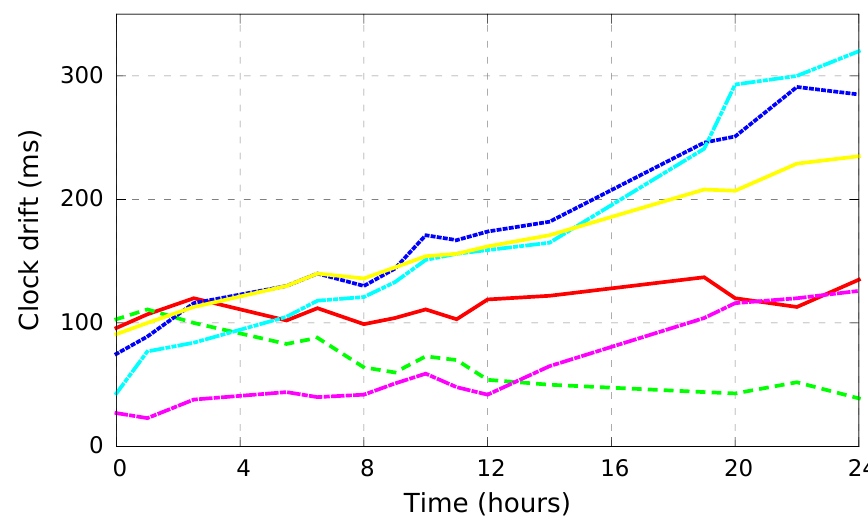
Figure 4. Smartphones clock